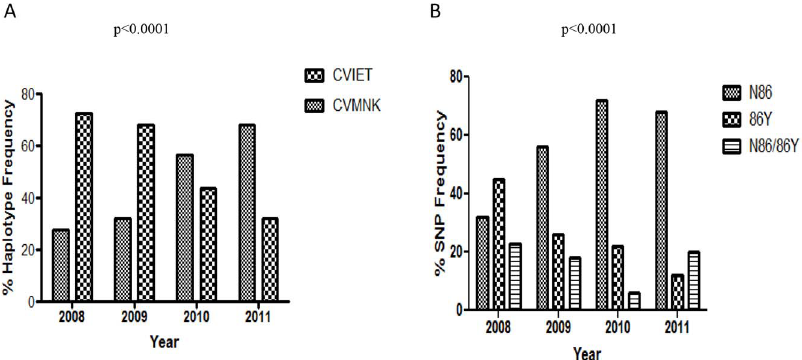
Figure 3. Frequency of Pfcrt 72-76 haplotype and Pfmdr1 N86Y SNP. A. Pfcrt 72-76 haplotype frequency per year; B. Pfmdr1 N86Y SNP frequency per year. Statistical significance was determined by